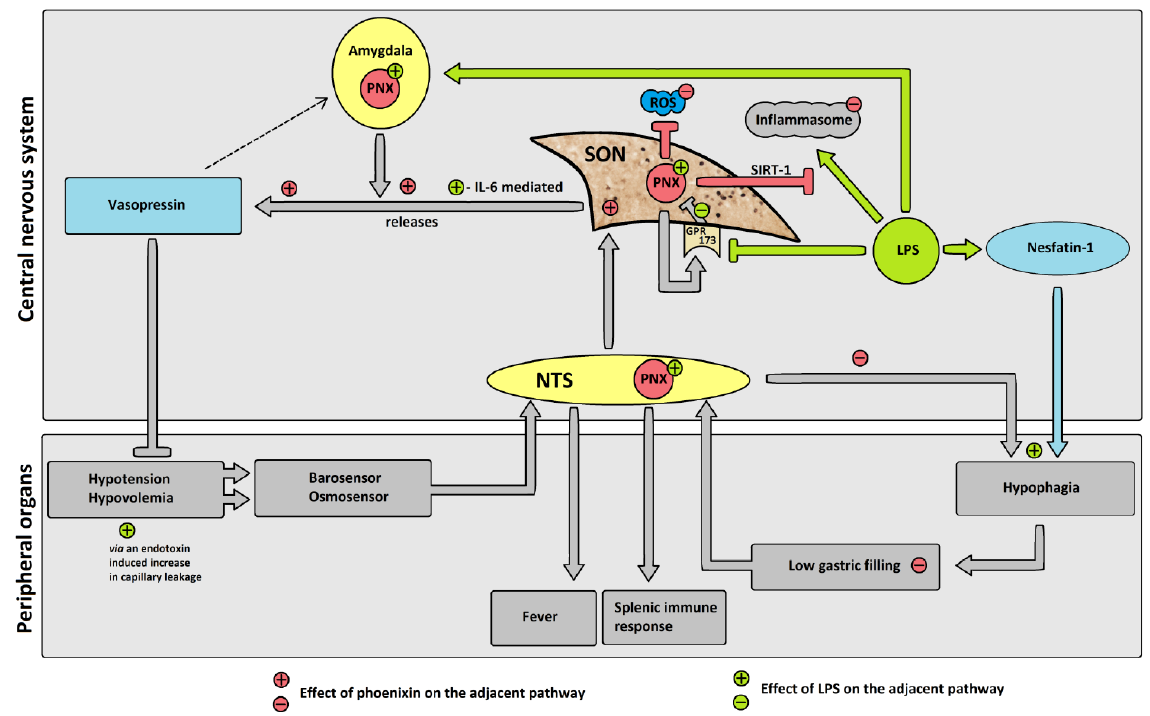
Figure 9. Hypothesized effects of LPS on phoenixin (PNX) and possible subsequent pathways. Gray pathways: proposed physiological pathway. Green pathways: proposed effects of LPS. Red pathways: proposed changes due to PNX. Adjacent +/ − in respective color: influence of LPS/PNX on physiological pathway. LPS reduces GPR173 expression, thereby decreasing the negative feedback of GPR173 on PNX expression, leading to an increase in phoenixin expression. Increased PNX leads to an increase in vasopressin secretion. Inflammasome activation due to LPS is reduced by PNX via the SIRT-1 pathway. PNX reduces ROS. PNX induces eating (i.e., reduces hypophagia) and thereby